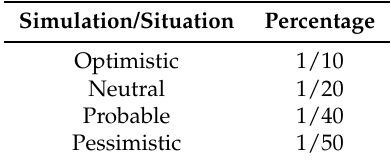
Table 3. Different simulations and their percentages.